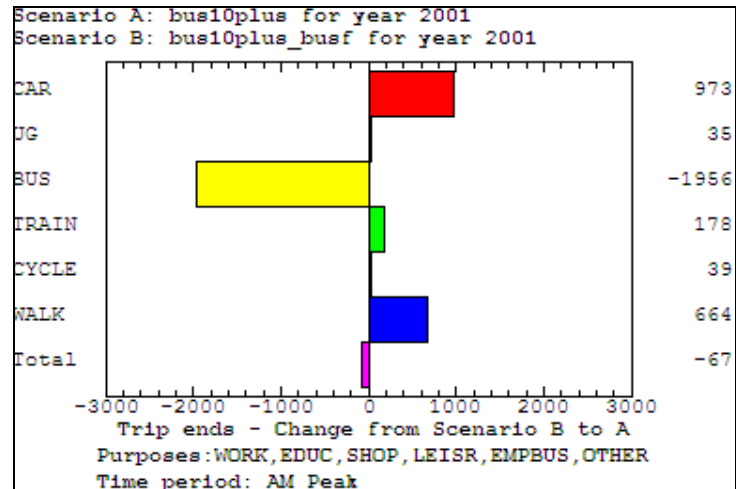
Figure 10. Absolute comparison for policy bracket run of bus fares with a standard run with 10% increase in bus